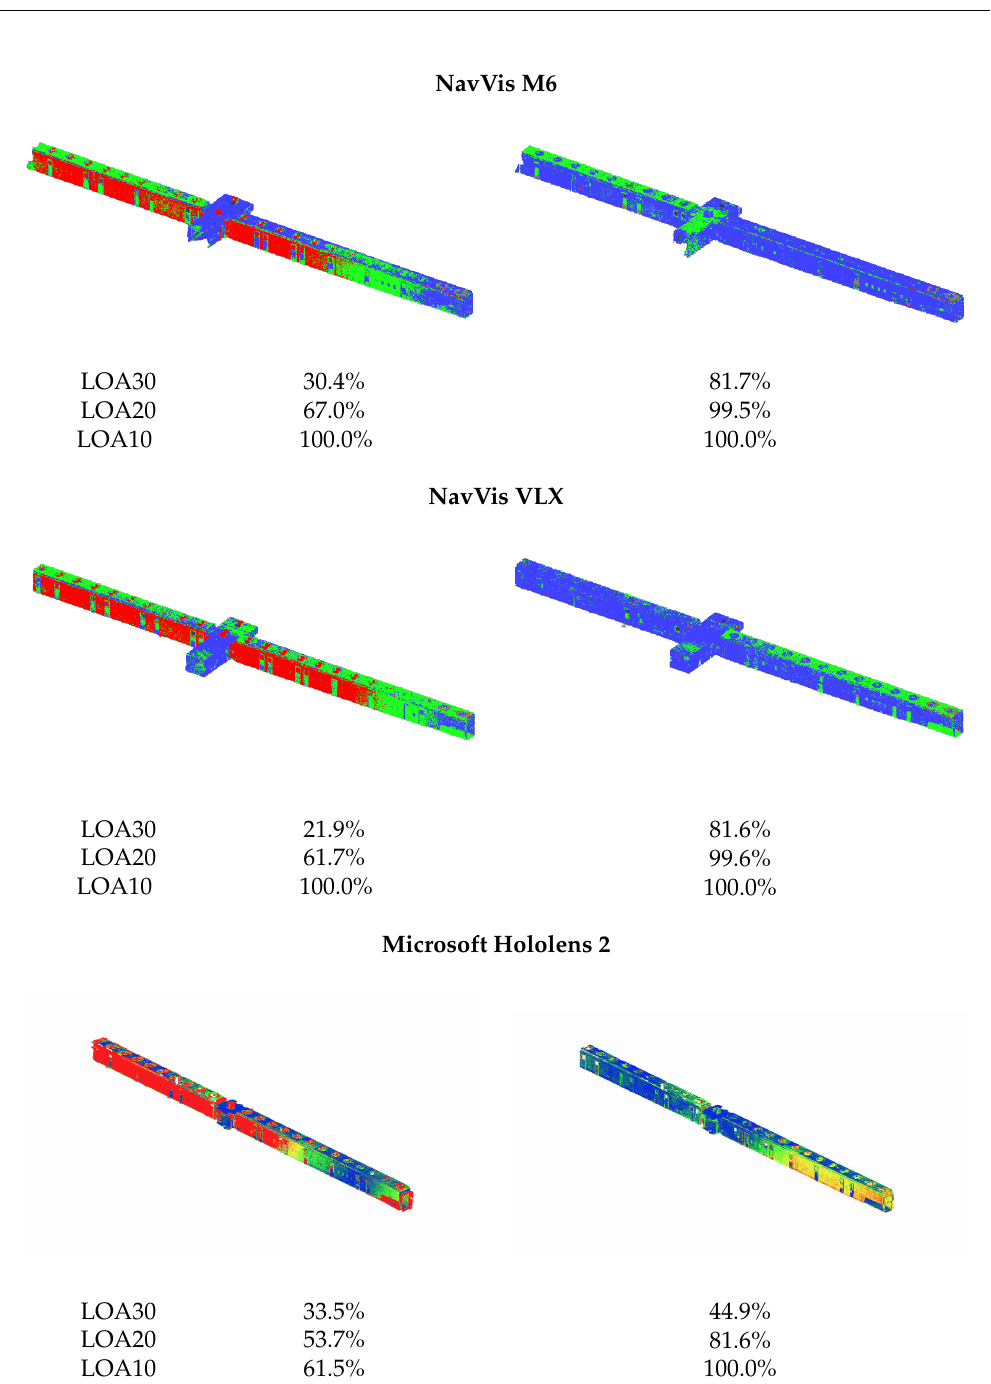
Figure 5. Impact of control points on the sensor capacity (D-hall): c2c analysis of the point clouds captured ( left ) without and ( right ) with control points compared to the P30 point clouds. Color scale is indicated from 0 m (blue) to 0.1 m